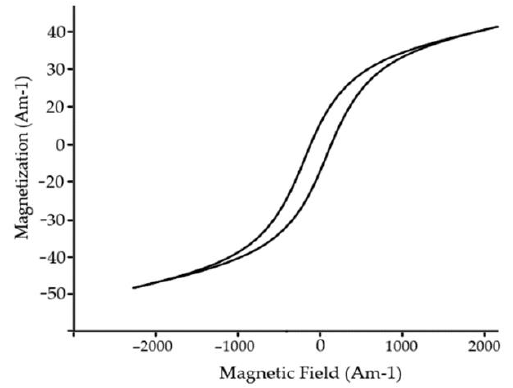
Figure 15. Typical magnetic loop of BFO thin film.